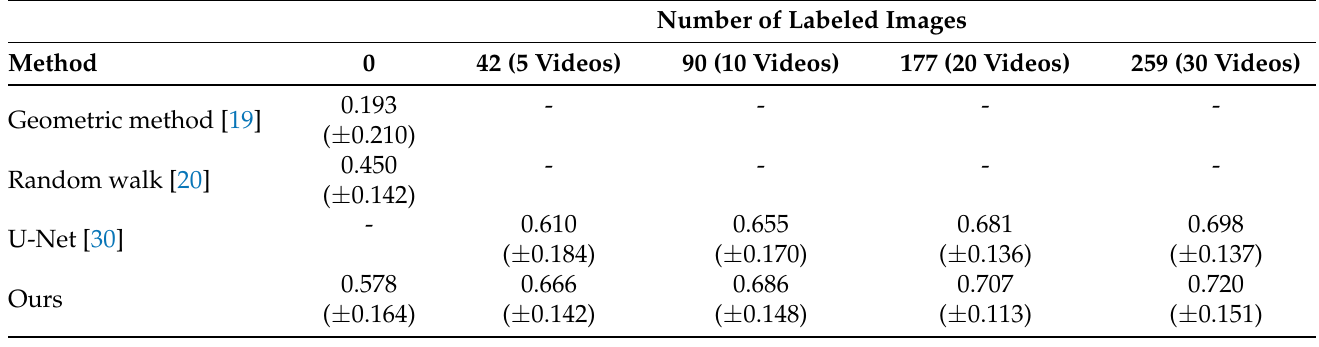
Table 1. Results of shadow detection evaluated in the DICE score. The scores are calculated for each testing image, and means over them are shown. The numbers in parentheses are the standard deviations.